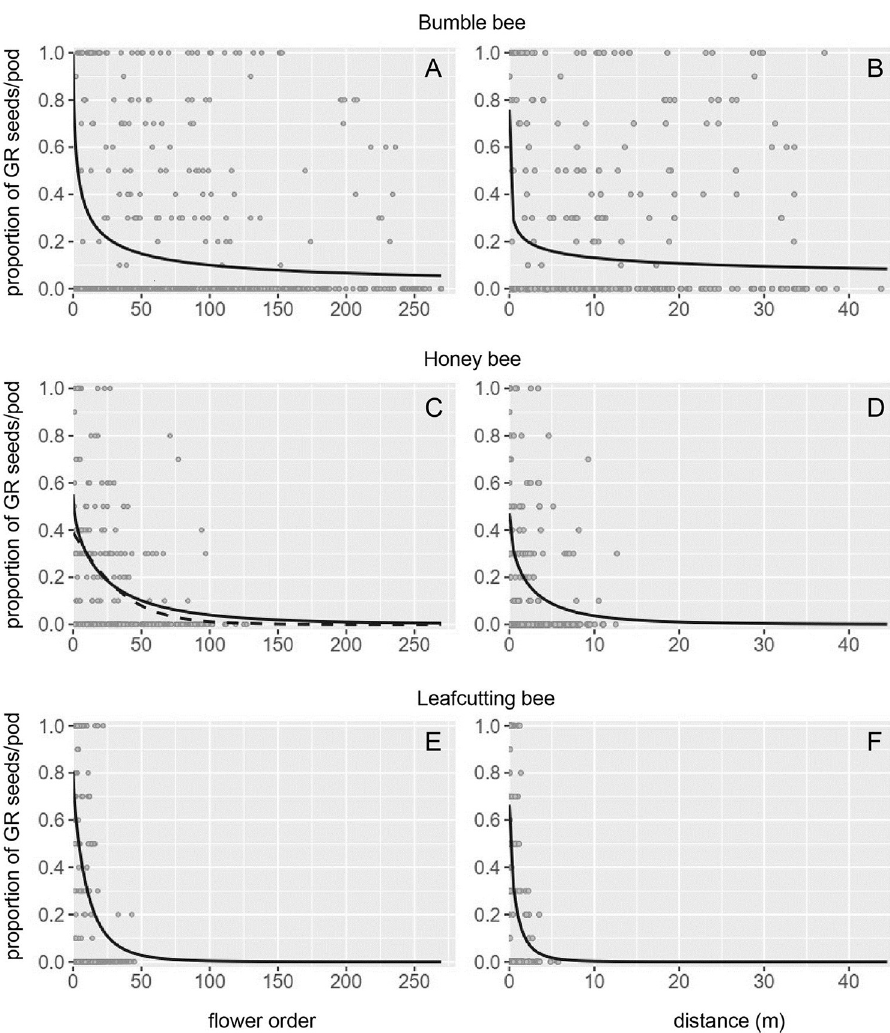
Fig 2. Probability of getting GR seeds in a pod with increasing flower order or distance traveled (m) by a bee. Probabilities represent back transformed logits (see text for details). For bumble bee, the log model with random intercept was the best model for both (A) flower order and (B) cumulative distance; for honey bee, the square root (solid line) and the standard (dashed line) models with random intercept were equally good candidates for (C) flower order while the square root model with random intercept was the best model for (D) distance; for leafcutting bee, the square root model with random slope and random intercept was the best model for both (E) flower order and (F)